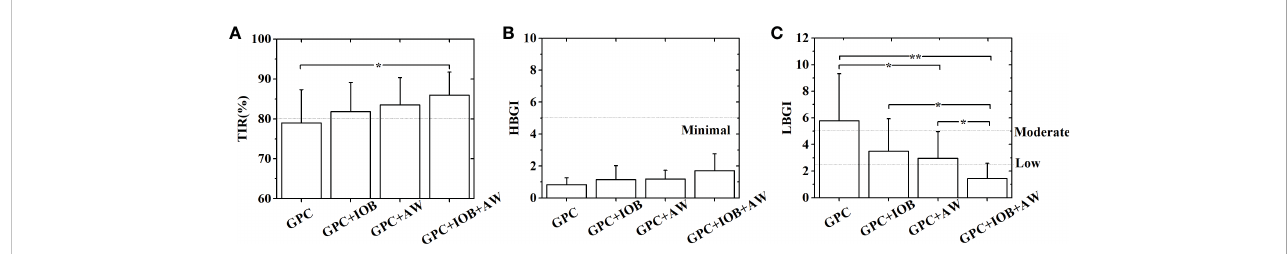
FIGURE 5 Statistical analyses of the TIR (A) , HBGI (B) and LBGI (C) of 9 in-silico subjects with different GPC controllers. Statistical analysis was performed in two steps: First, F-tests were performed to compare variances of the data sets. Then T-tests are conducted to further examine the differences between the